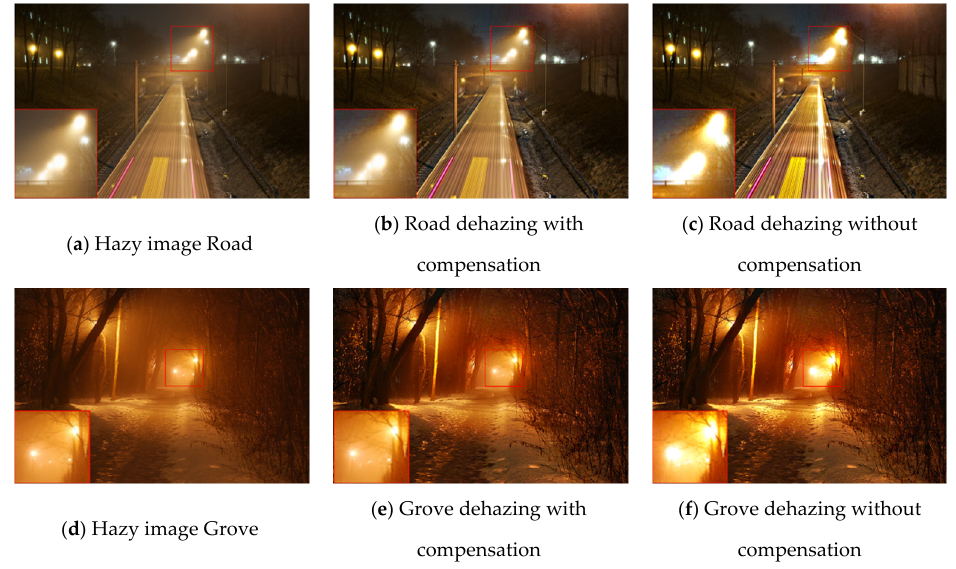
Figure 3. Comparison of the high ‐ light compensation effects.